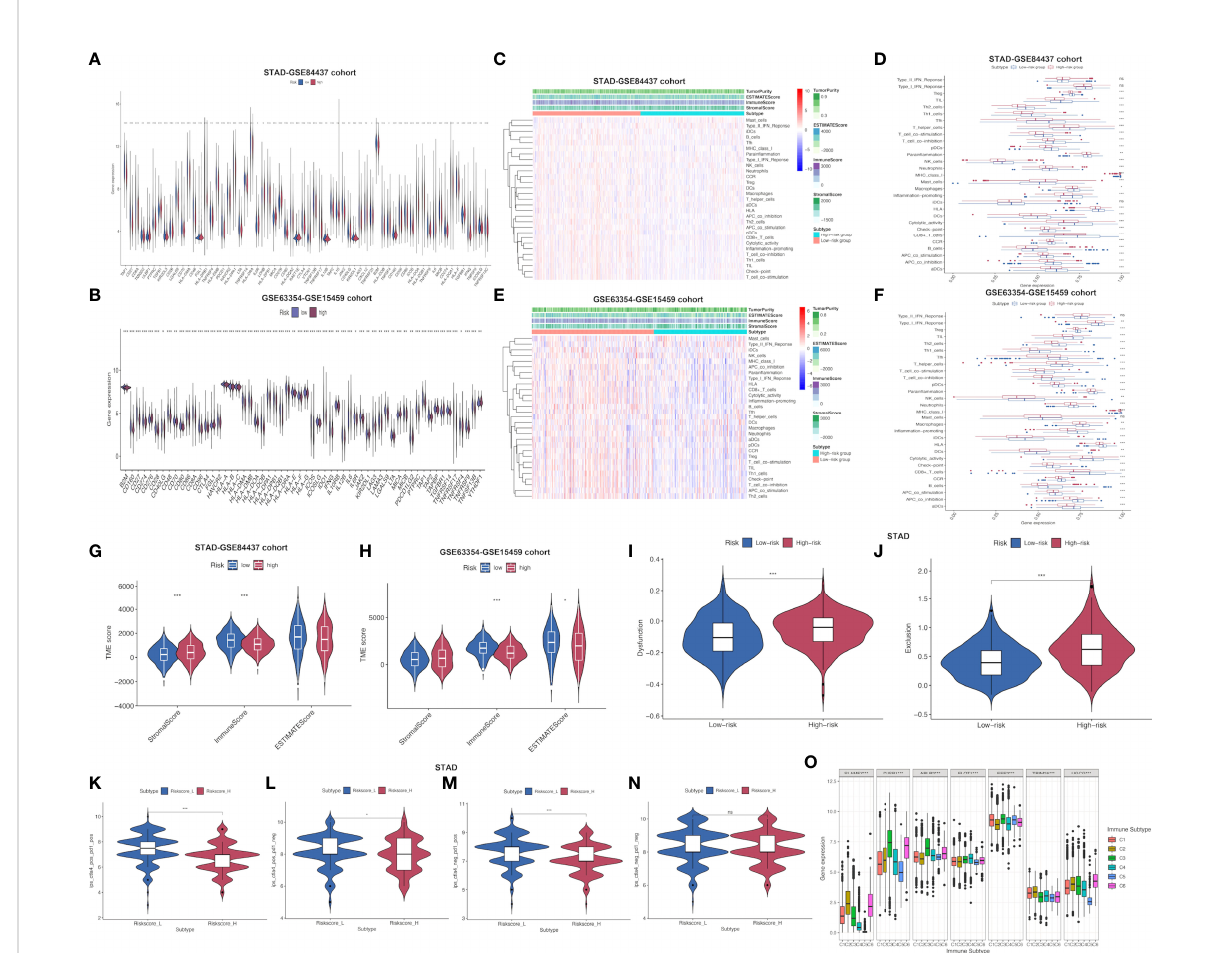
FIGURE 5 Assessment of distinct immune landscapes between high-and low-risk groups in both cohorts. (A, B) Differential expression of immune − related genes between high- and low-risk groups in STAD-GSE84437 and the external validation cohort, respectively. (C, D) Immune-related functions differ between high- and low-risk groups for STAD-GSE84437. (E, F) Immune-related functions differ between high- and low-risk groups for the external validation cohort. (G, H) Differences in immune score, stromal score, and ESTIMATE score between low- and high-risk groups in STAD- GSE84437 and the external validation cohort, respectively. (I) Different T cell dysfunction scores between high- and low-risk groups in STAD- GSE84437. (J) Different T cell exclusion scores between high- and low-risk groups in STAD-GSE84437. (K – N) Analysis of potential differential responses to immune checkpoint inhibitors therapy in low- and high-risk groups of patients in TCGA-STAD using TCIA data. (O) Association of the expression of model genes with immune in fi ltrate subtypes across all the cancer types in TCGA. STAD, stomach adenocarcinoma; ESTIMATE, estimation of Stromal and Immune cells in Malignant Tumors using Expression data; TCIA, The Cancer Immunome Atlas. *P<0.05; **P<0.01;